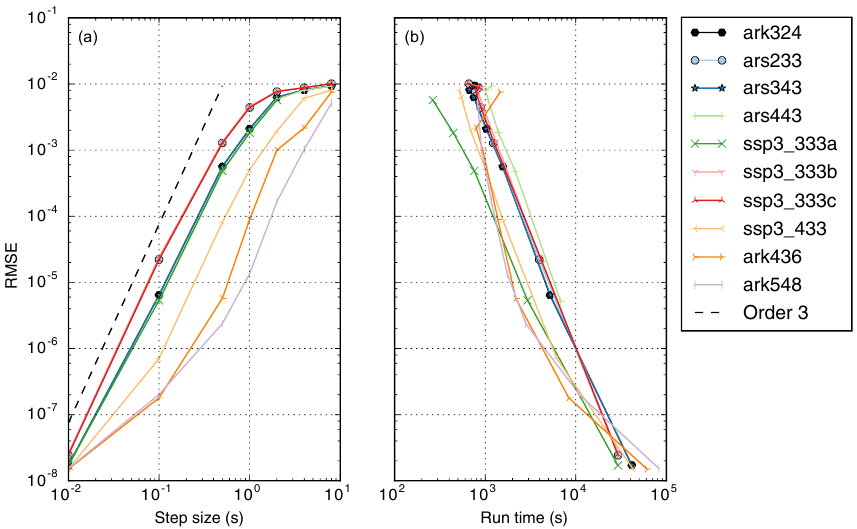
Figure 6. Accuracy (a) and efficiency (b) for the third-, fourth-, and fifth-order methods using the Rosenbrock-like approach with the IMEX- B splitting. The dashed line represents third-order convergence. Results using multiple Newton iterations to compute the stage solutions give nearly identical error values to the Rosenbrock-like results but increase the computational cost by at least